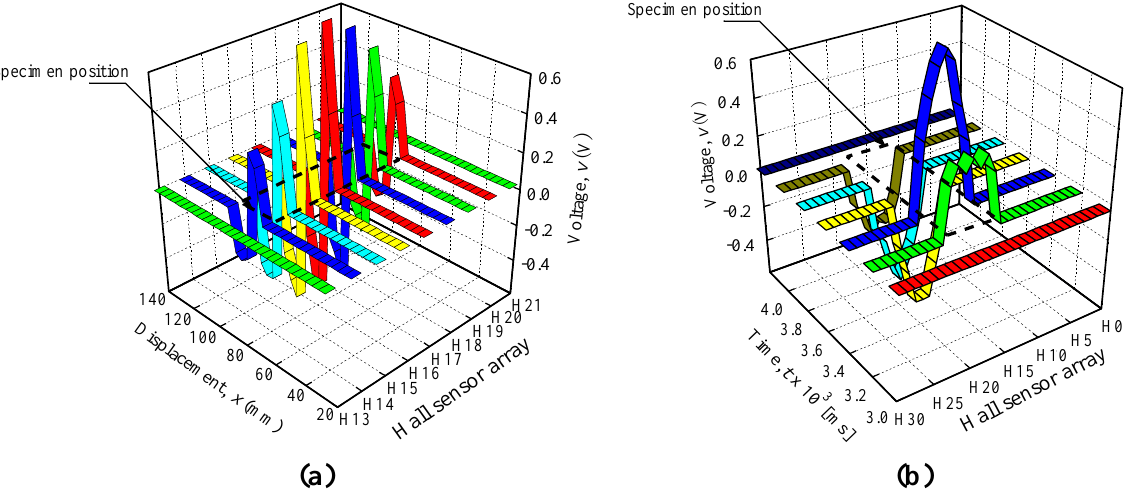
Figure 8. Data arrangement and distribution constructed with the H-SAP application based on 1-D Hall sensor array signals for a square shape specimen. ( a ) Voltage value arrangement and distribution based on the z axis of Hall sensor array direction and x axis of displacement. ( b ) Voltage value arrangement and distribution base on the time axis t and z axis of Hall sensor array